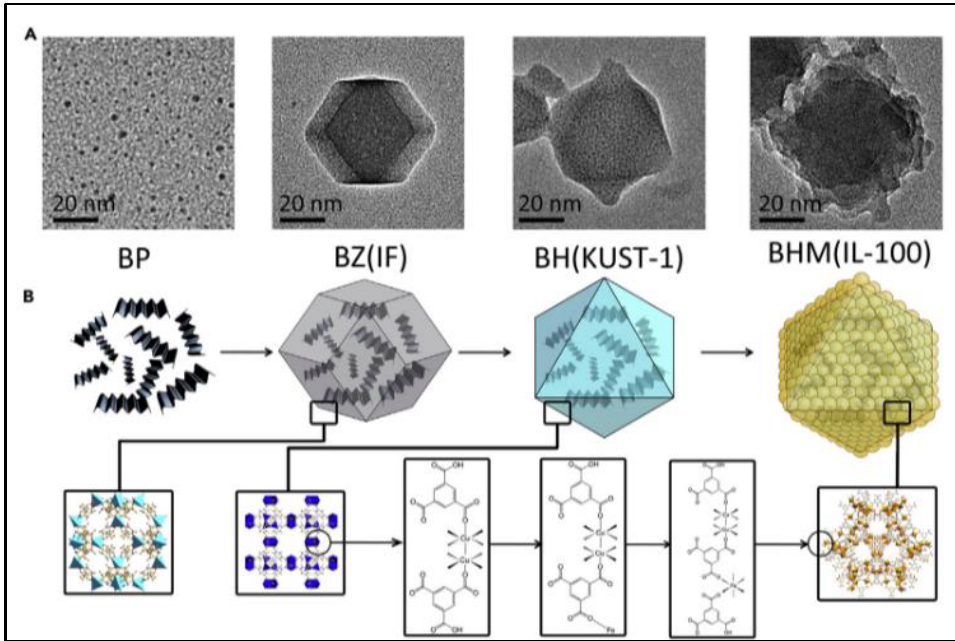
Figure 6. Schematic illustration of synthesis and characterization of core-shell MOF (HKUST-1@MIL-100(Fe)) nano-formulation. ( A ): Transmission electron microscope (TEM) images; ( B ): topological structures [45]. BP: black phosphorous quantum dots; BZ: black phosphorous quantum dots loaded ZIF-8 nanoparticles; BH: black phosphorous quantum dots loaded HKUST-1 nanoparticles. BHM: black phosphorous quantum dots loaded HKUST-1@MIL-100(Fe) nanocomposites.